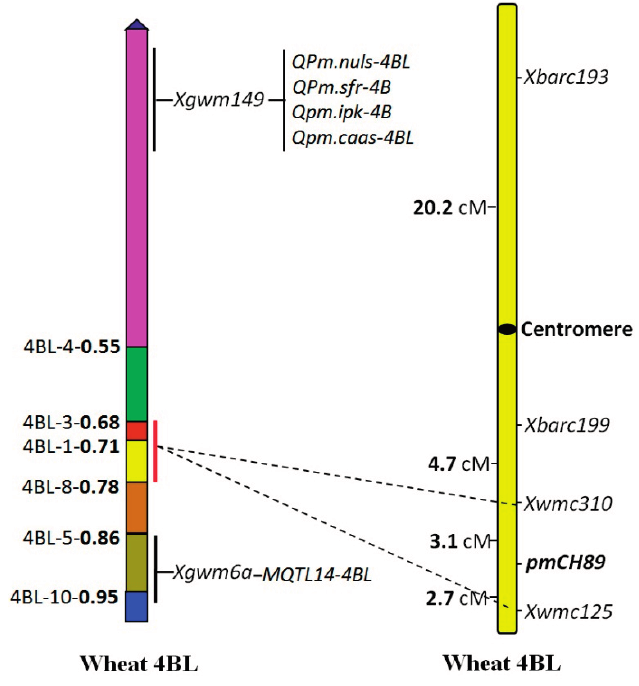
Figure 4. Genetic and deletion bin position of pmCH89 on chromosome